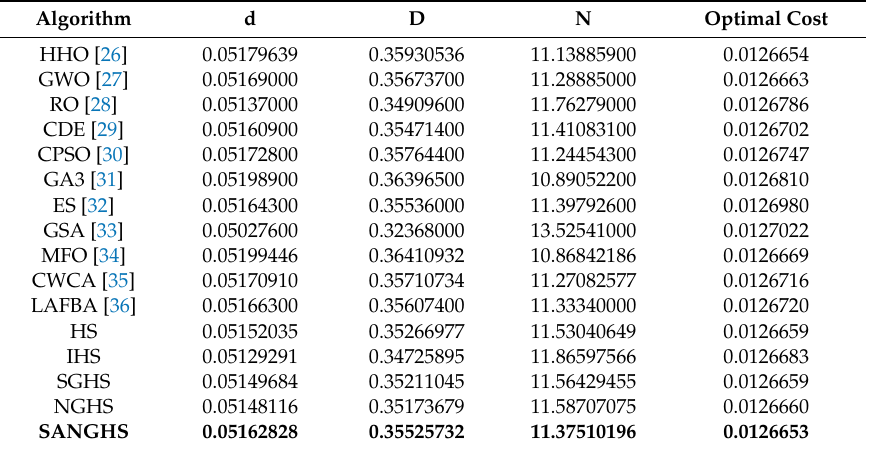
Table 7. Experimental results in the tension / compression spring design engineering problem.